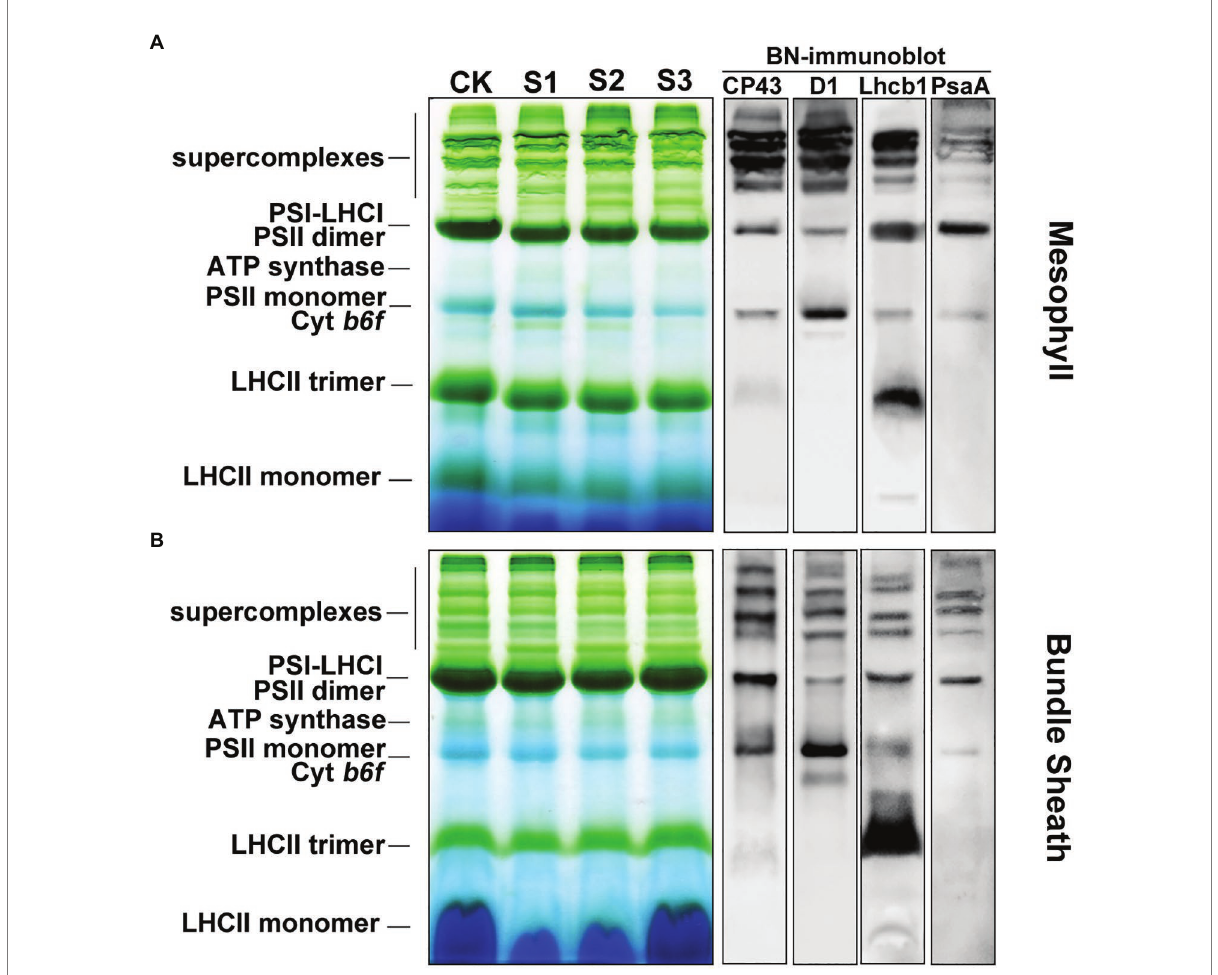
FIGURE 7 The composition of protein complexes in M and BS thylakoids of maize leaves under drought stress. (A) Membranes (15 μ g Chl) in M thylakoids were solubilized with 1% n-dodecyl β -D-maltoside (DDM) and loaded onto 4%–12% acrylamide Blue-Native gel. (B) Membranes (15 μ g Chl) in BS thylakoids were solubilized with 2% DDM and loaded onto 4%–12% acrylamide Blue-Native gel. The bands of BN-PAGE were confirmed by immunoblotting with CP43, D1, Lhcb1, and PsaA specific antibodies (on the right). The control line of the BN gel was selected for immunodetection. The results shown are representative of those obtained in at least three independent experiments. CK, S1, S2, and S3 represent, respectively, the well-watered, mild drought, moderate drought and severe drought